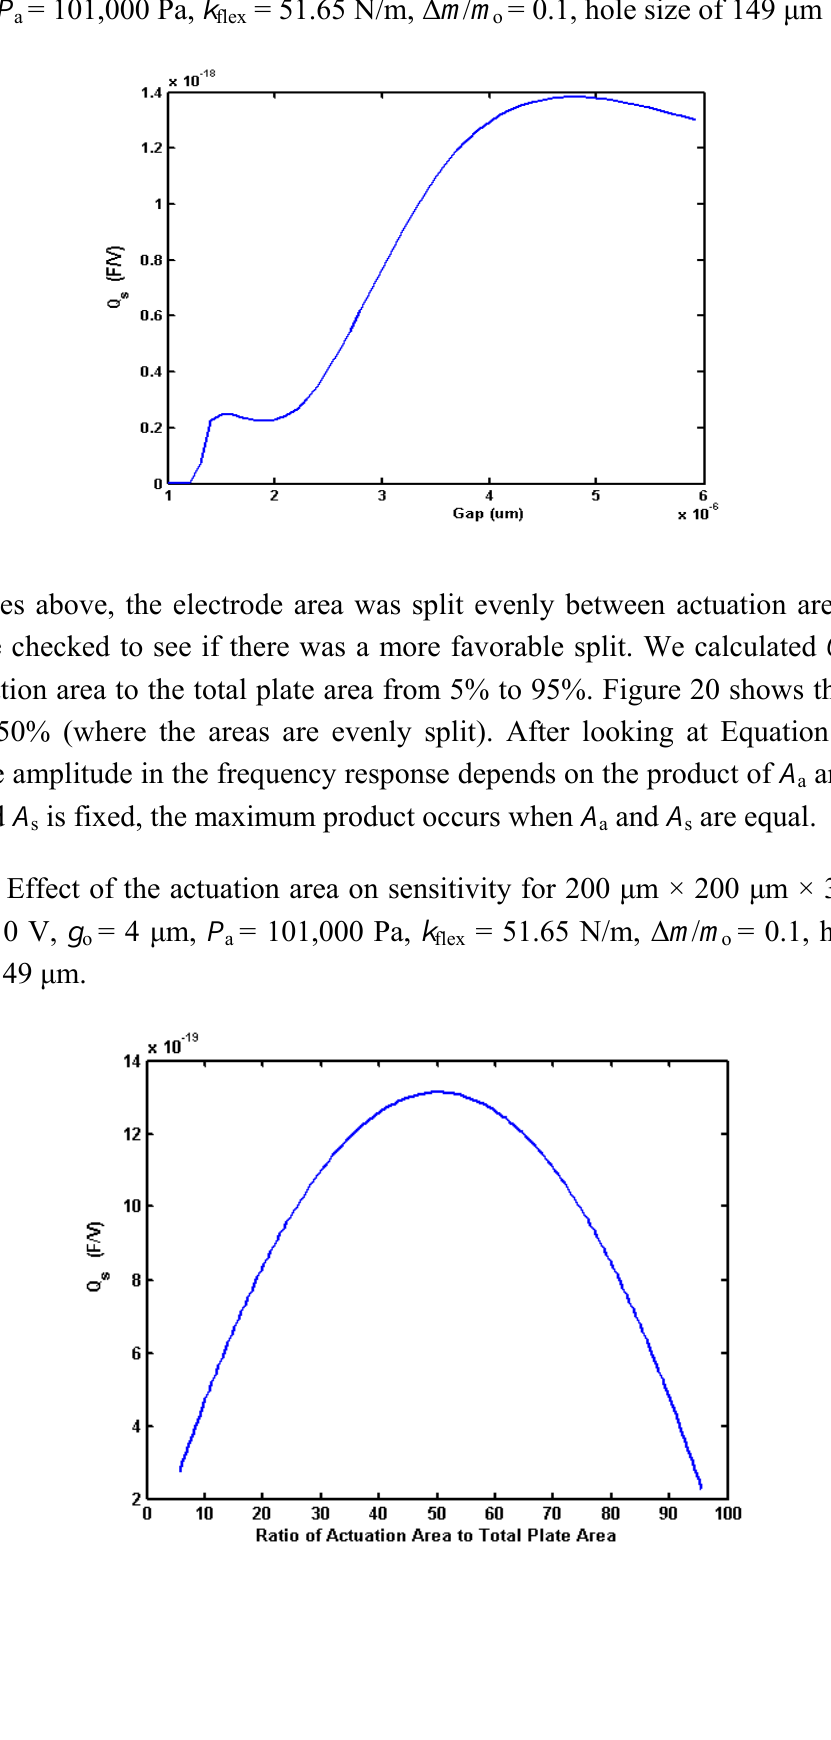
= 0.1, hole size of 149 μ m × 149 μ m. o